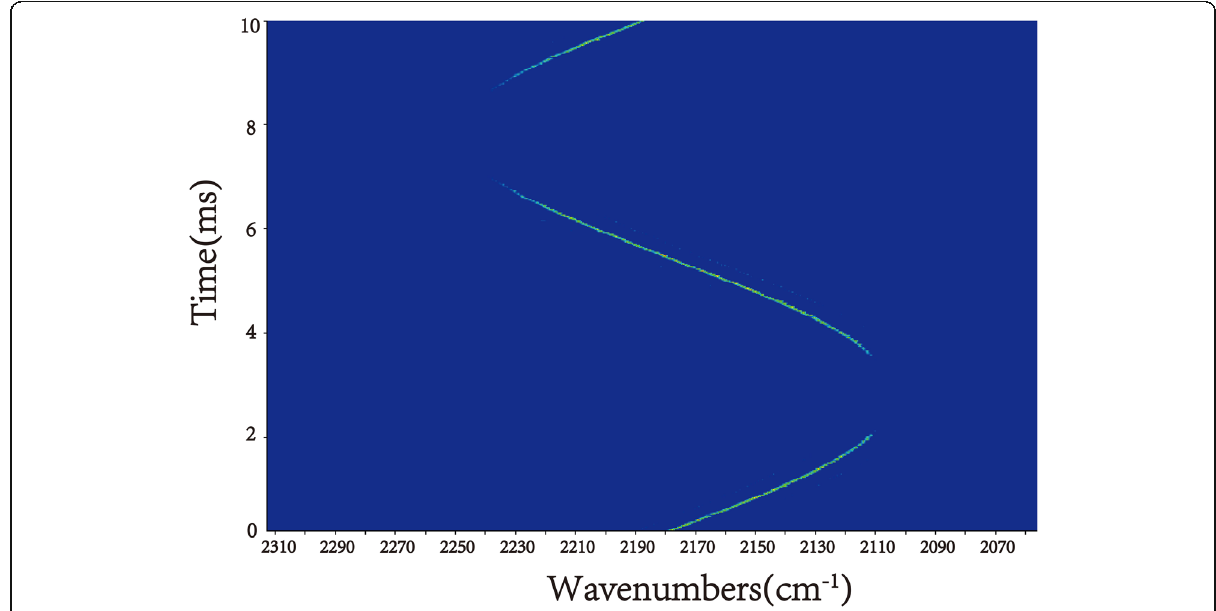
Fig. 4 The time-resolved emission peaks of the EC-QCL operated in cw mode at 330 mA and the scanning galvanometer modulation at 100